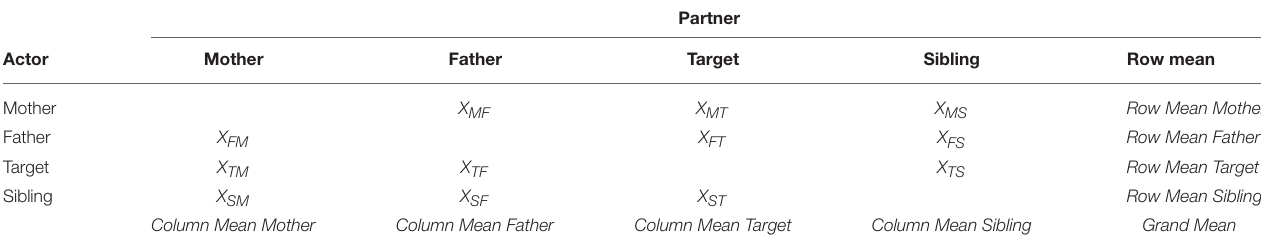
TABLE 1 | Raw dyadic scores according to a two-way ANOVA design.